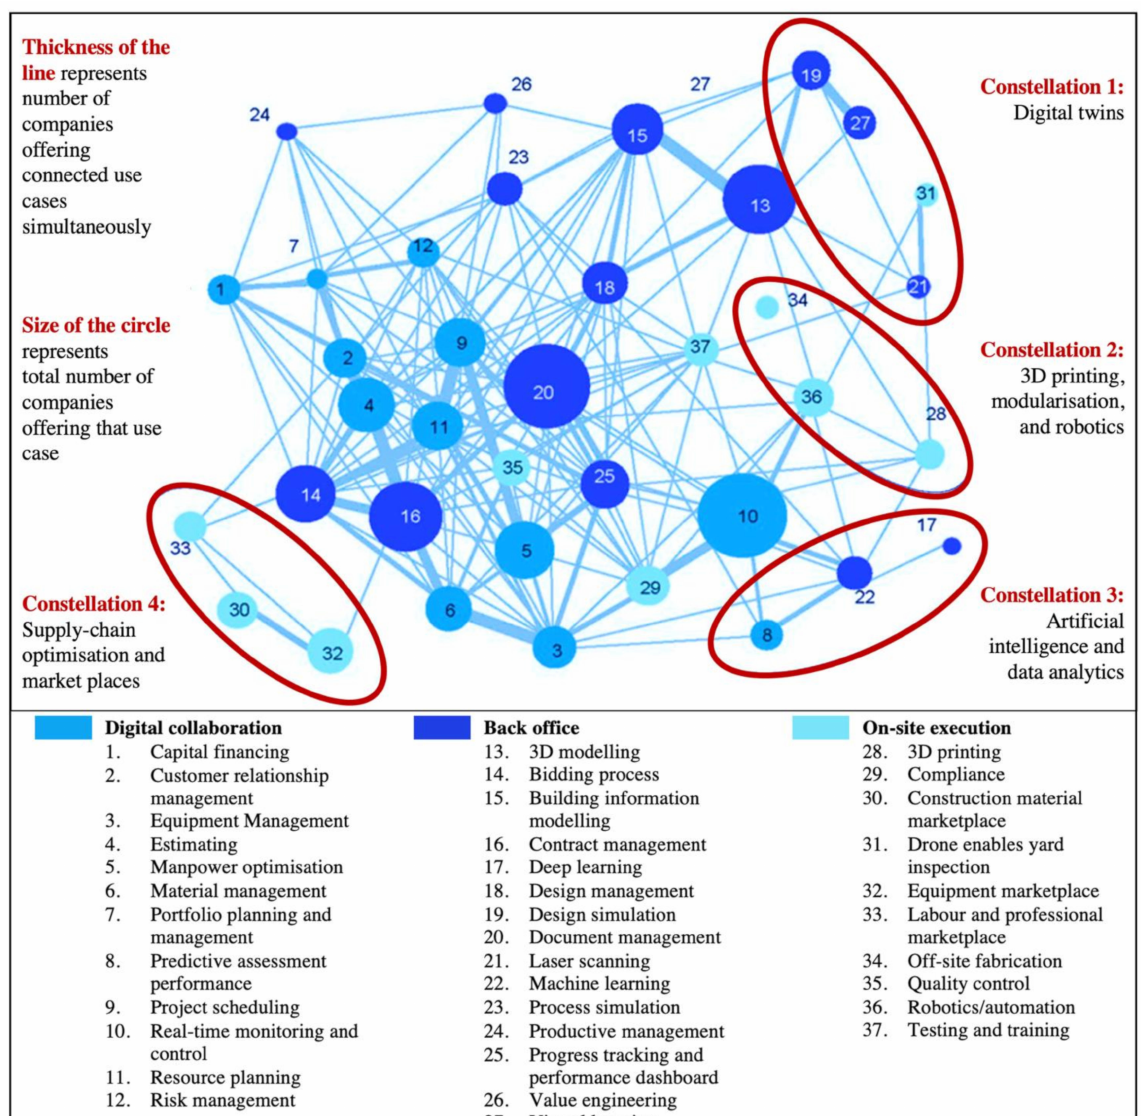
Figure 1. Construction technology map, derived from